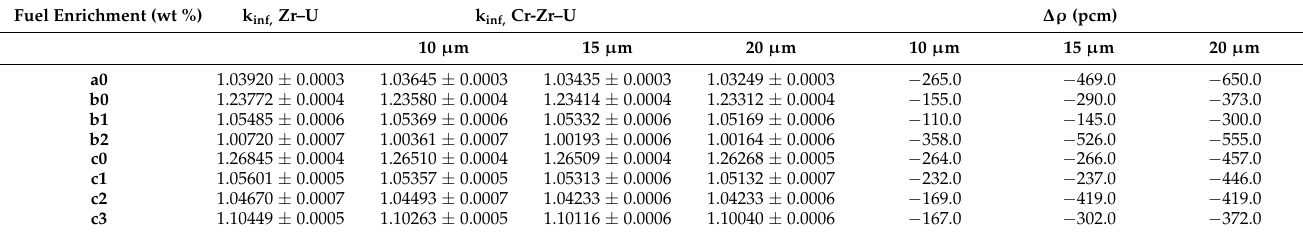
Table 6. k inf values and reactivity difference at BOC for APR-1400 fuel assemblies.